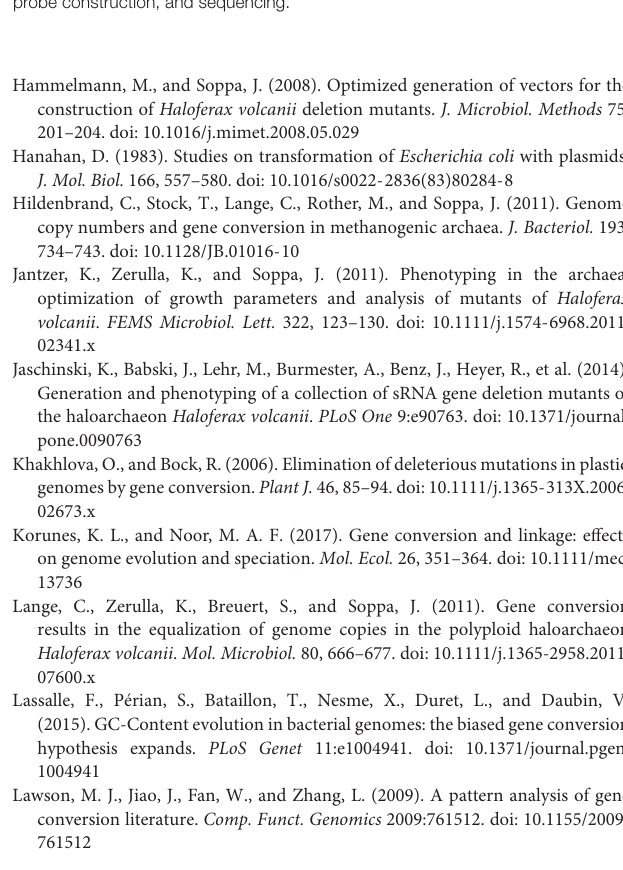
Supplementary Table 1 | Overview of strains and their genotypes. Supplementary Table 2 | Results of the gene conversion experiment shown in Figure 2 . Supplementary Table 3 | Results of the gene conversion experiment shown in Figure 4 . Supplementary Table 4 | Results of the gene conversion experiment shown in Figure 5 . Supplementary Table 5 | Results of the gene conversion experiment shown in Figures 6 , 7 A. Supplementary Table 6 | Results of the gene conversion experiment shown in Figure 7B